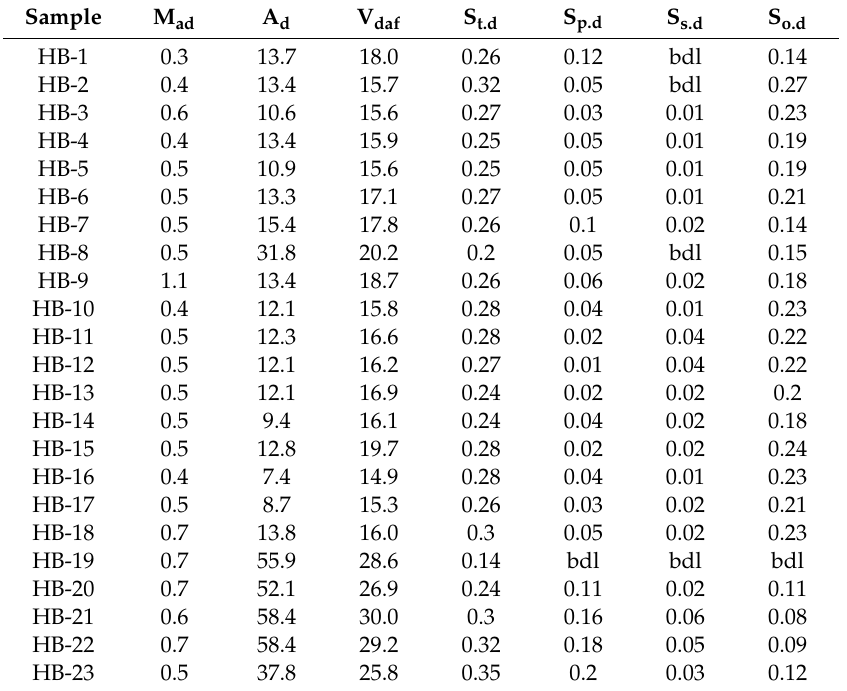
Table 2. Proximate analysis (%) and sulfur (%) contents of the samples from the Hebi No. 6 mine.